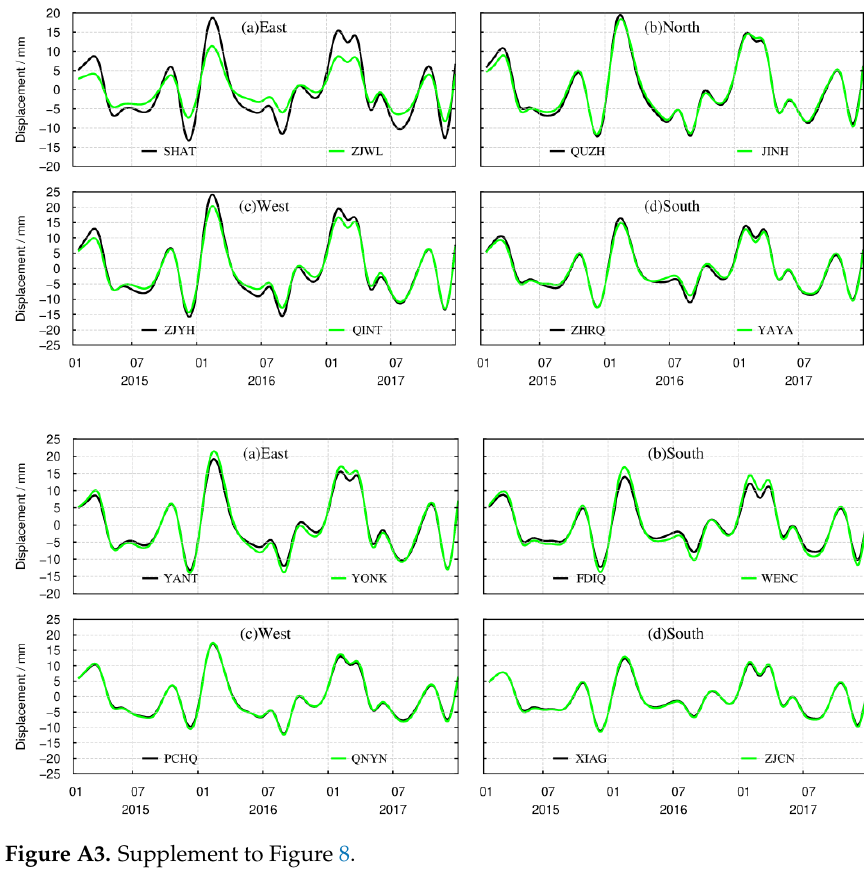
4. Supplement to Figure 9. Figure A3. Supplement to Figure 8.